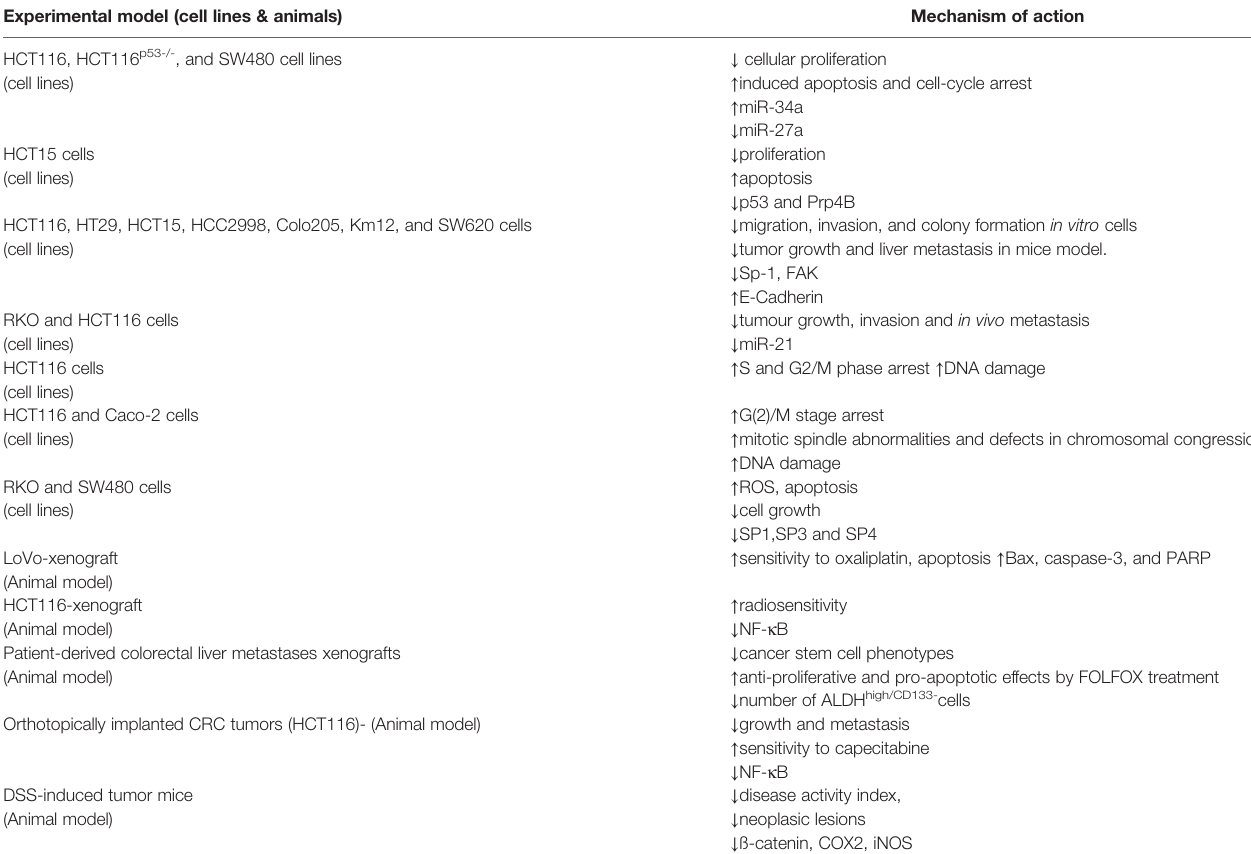
TABLE 1 | Mechanism of action of curcumin in colorectal cancer therapy (45). Experimental model (cell lines & animals) Mechanism of